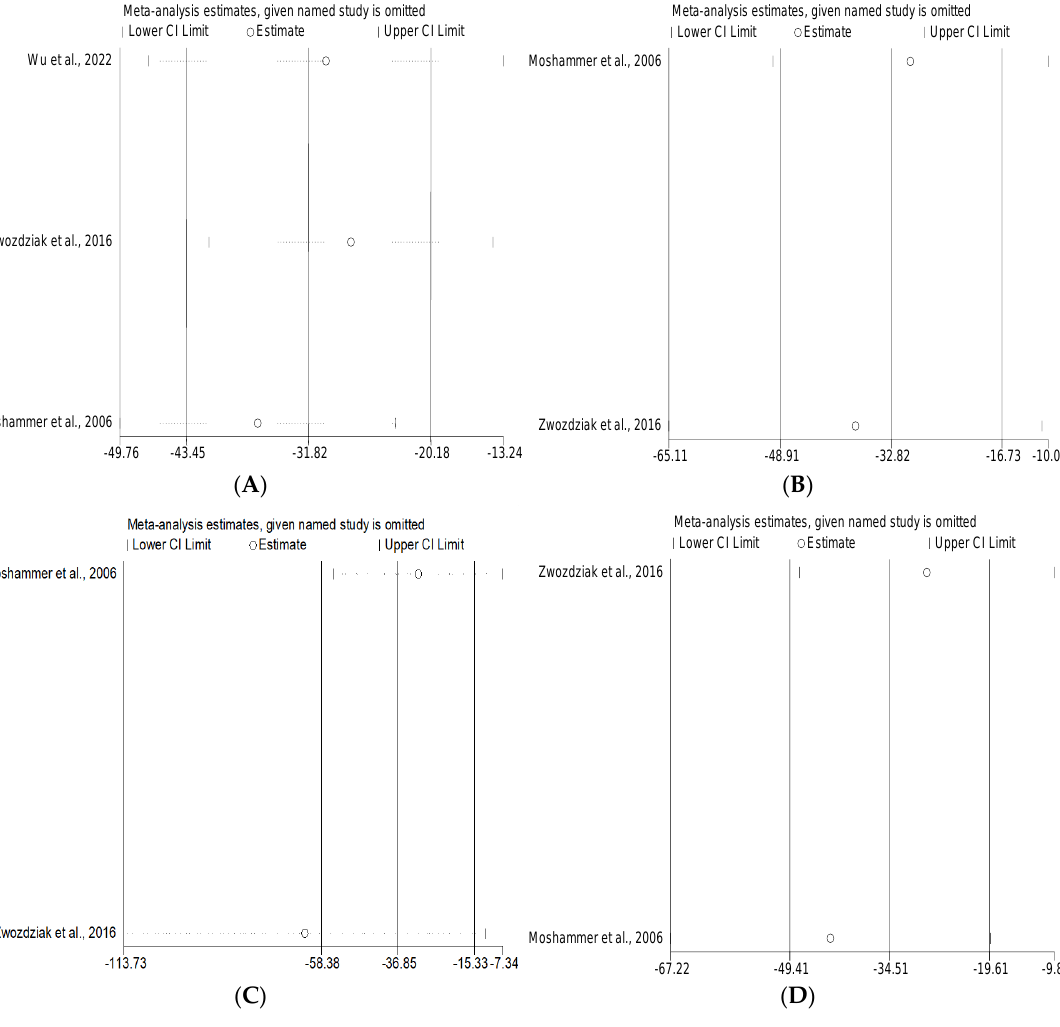
Figure 6. Sensitivity analyses of included studies in the short-term exposure group: ( A ) FVC, ( B ) FEV 1 , ( C ) PEF, ( D ) MMEF [31,32,36].